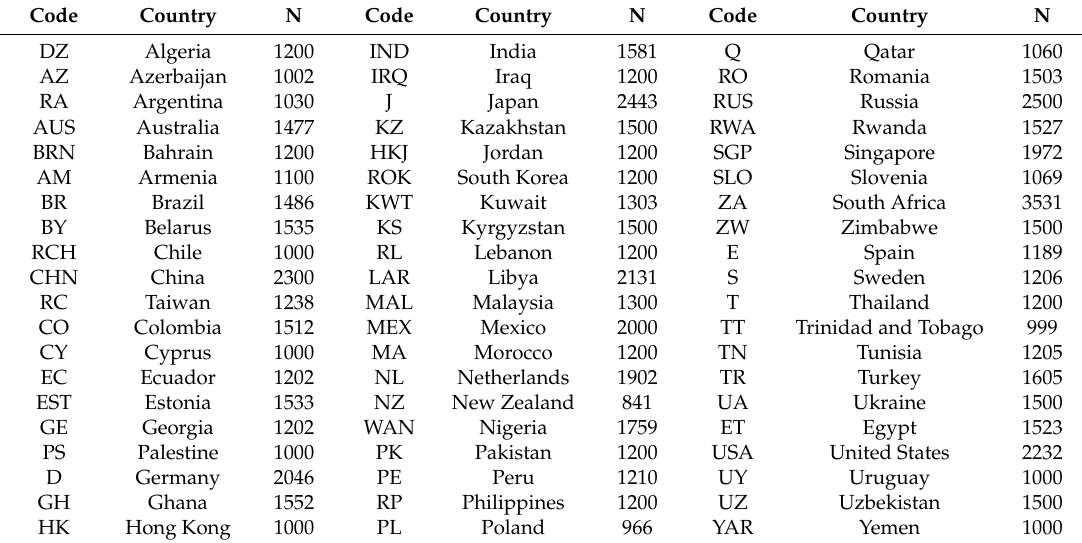
Table 1. List of the Countries.